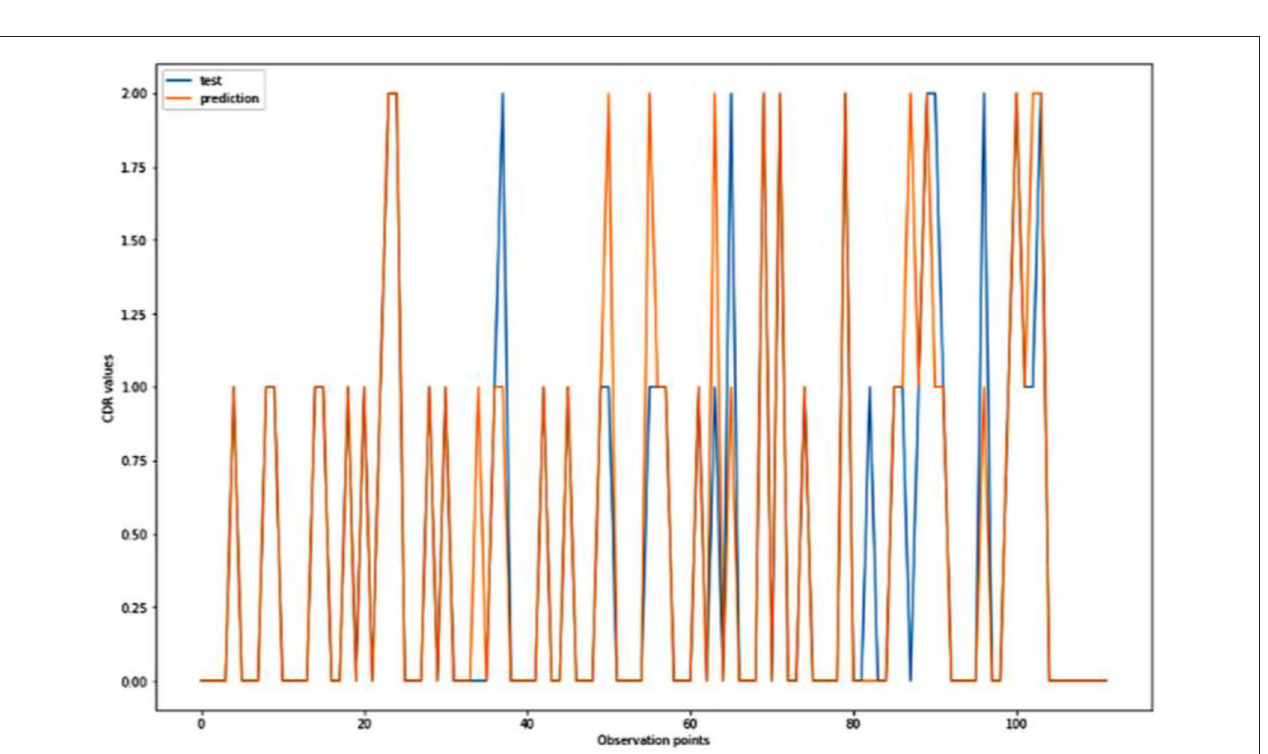
FIGURE 8 | Graphical representation of the comparison of test and predicted CDR values obtained using the TensorFlow model. (11 parameters).